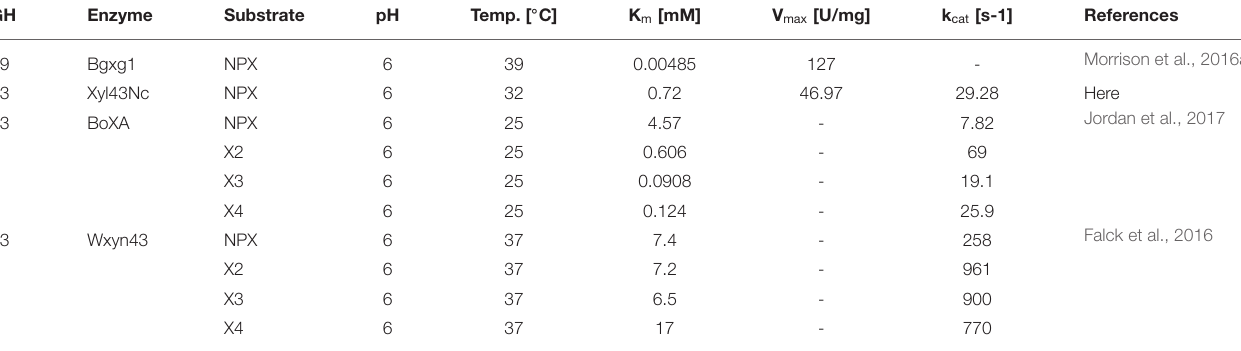
TABLE 2 | Biochemical properties of selected xylosidases on the substrates 4-nitrophenol-xylopyranoside (NPX), xylobiose (X2), xylotriose (X3) and xylotetraose (X4). GH